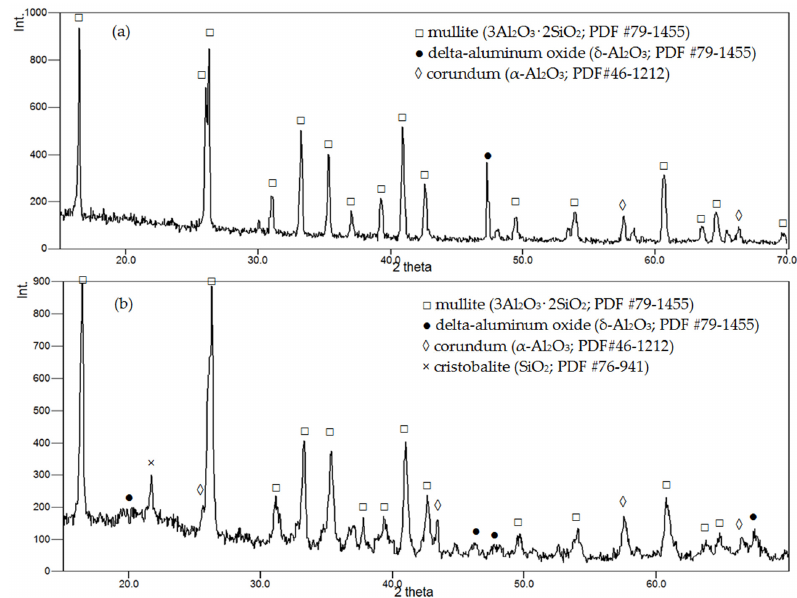
#76-941) appear in the diffraction pattern of the treated material II (Figure 6). The precision data obtained for the powder specimen II indicate the presence of the low-temperature modification of cristobalite. A quantitative assessment by the external standard method gives the following content of phase components: mullite—89%, δ -Al 2 O 3 —5%, α -Al 2 O 3 — 5%, cristobalite—1%. The diffraction pattern for the treated material III contains reflections from two new phase components—corundum and cristobalite (Figure 7). As in the case of the material I, an increased amount of α -Al 2 O 3 is observed on the surface of the “hot” side samples for the materials II, III.